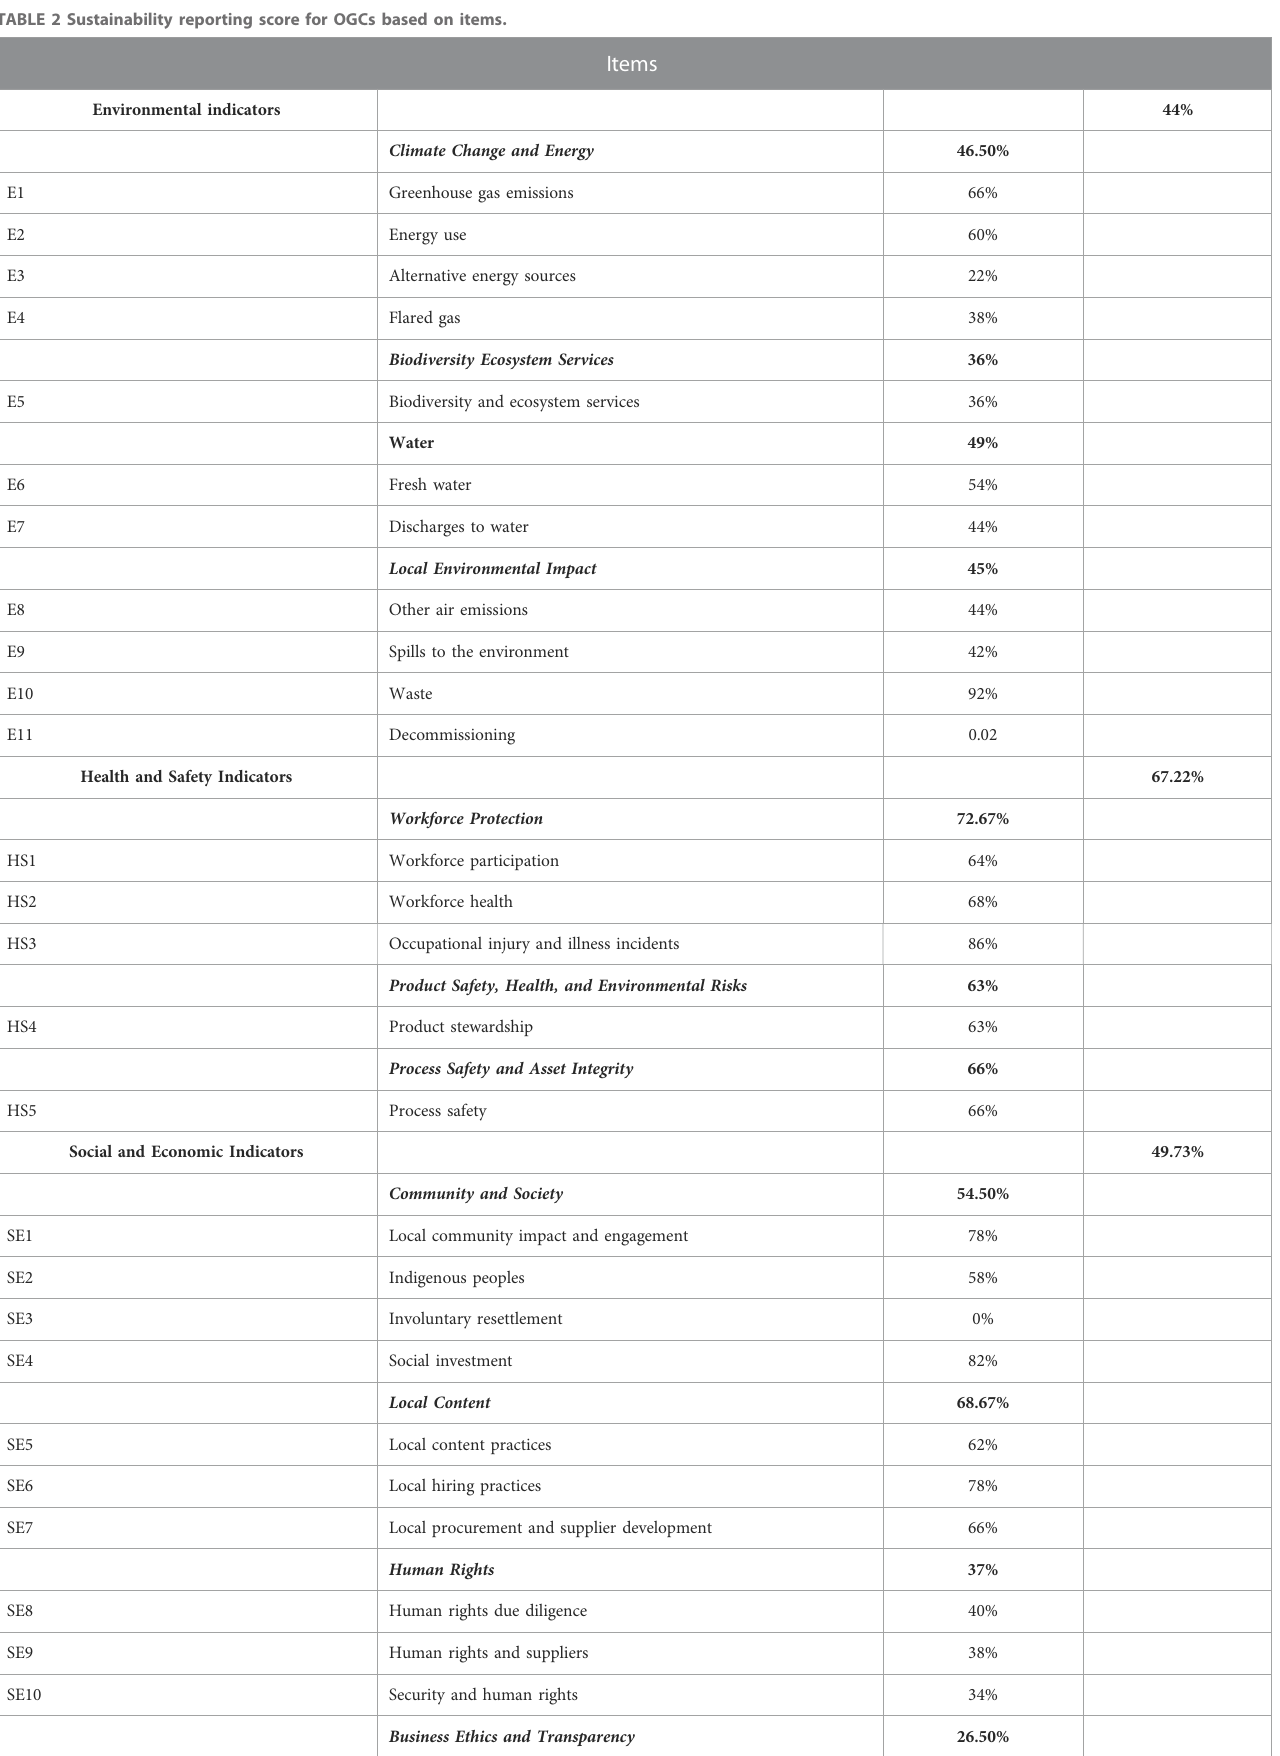
TABLE 2 Sustainability reporting score for OGCs based on items.